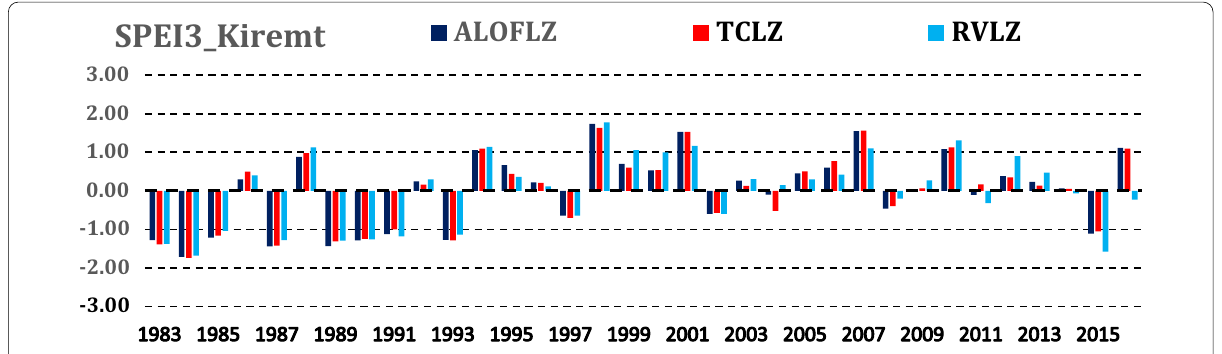
Fig. 5 Chart of temporal drought trends in Kiremt seasons from1983–2016